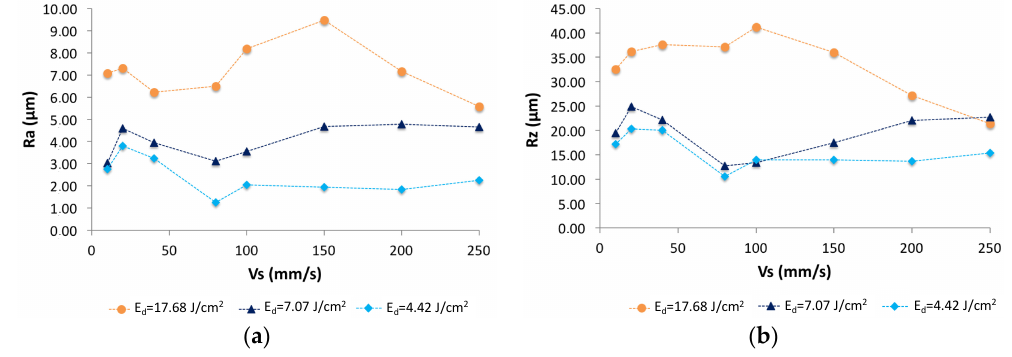
Figure 4. Surface finish ( a ) R a and ( b ) R z behavior with different laser processing parameters.